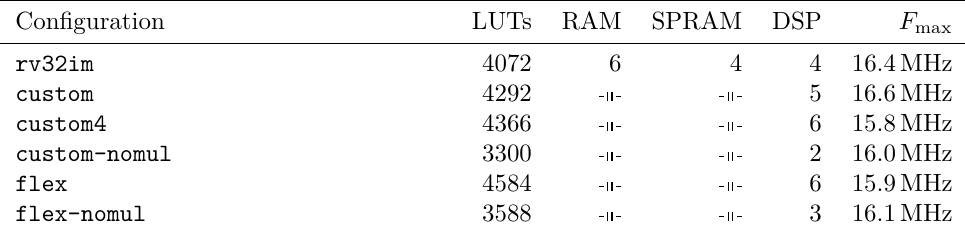
Table 5: iCE40 UltraPlus device utilization and speed for varying configurations.